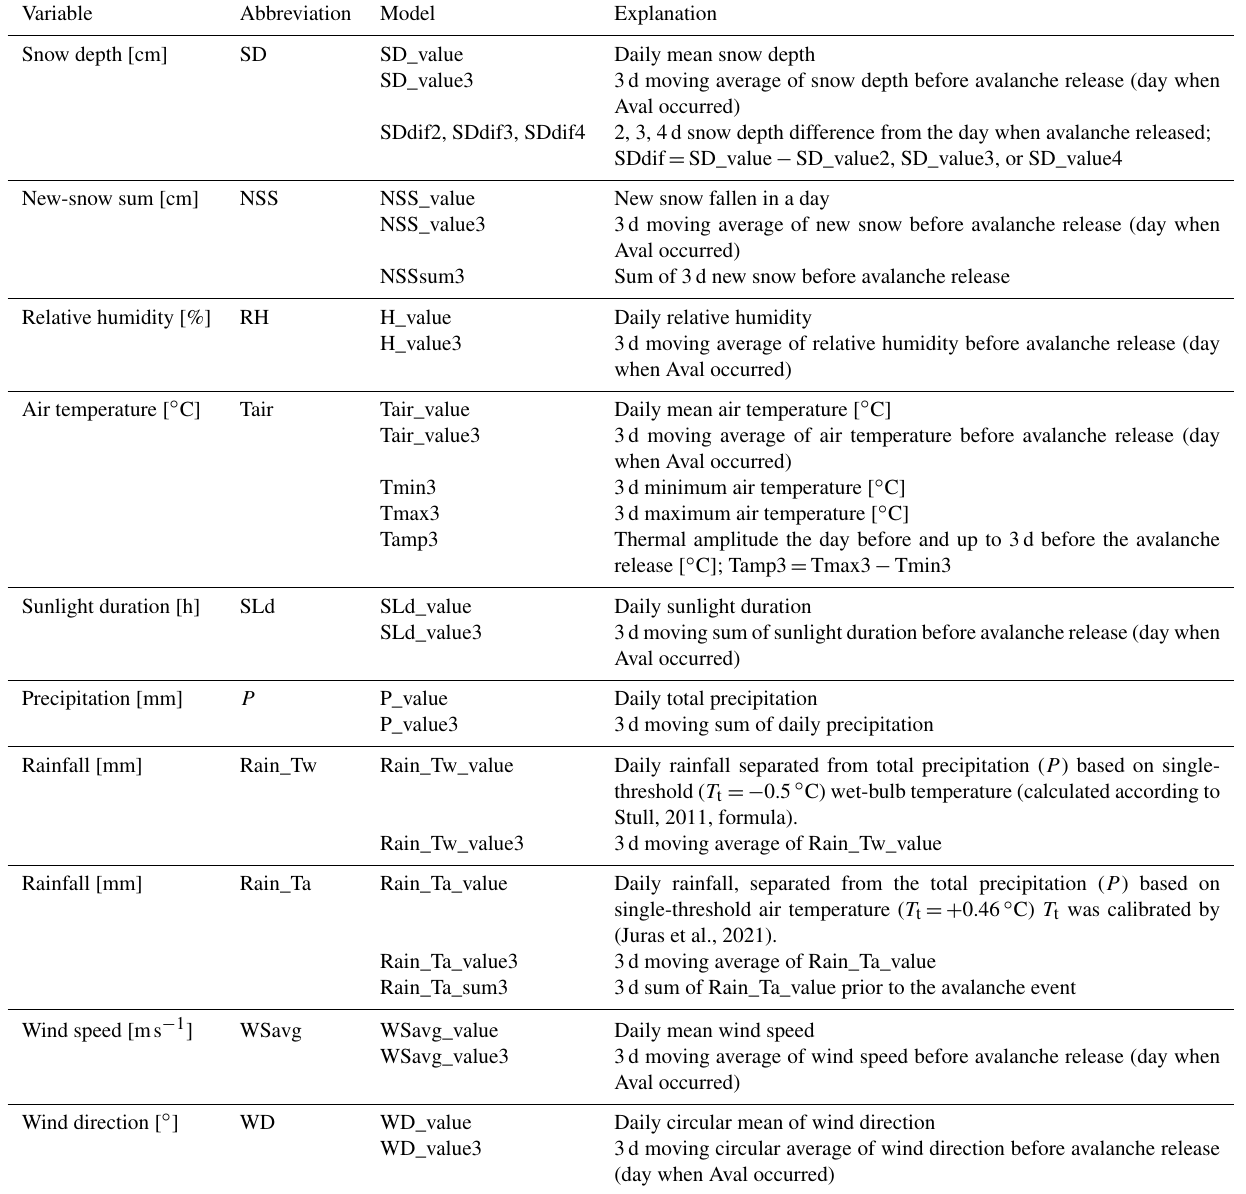
Table 1. Description of the weather variables used in this study.